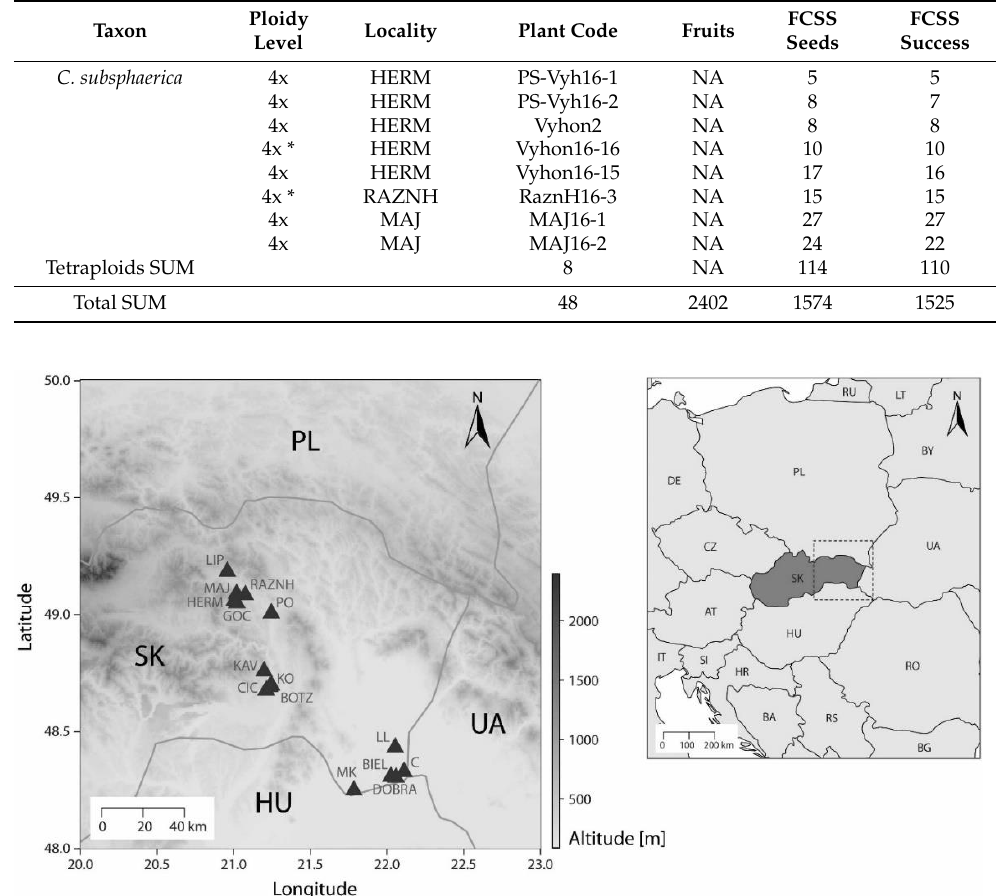
Figure 1. Location of the 15 investigated populations in eastern Slovakia, Central Europe. The population codes are as presented in Table 1 and Supplementary Material Note S1.